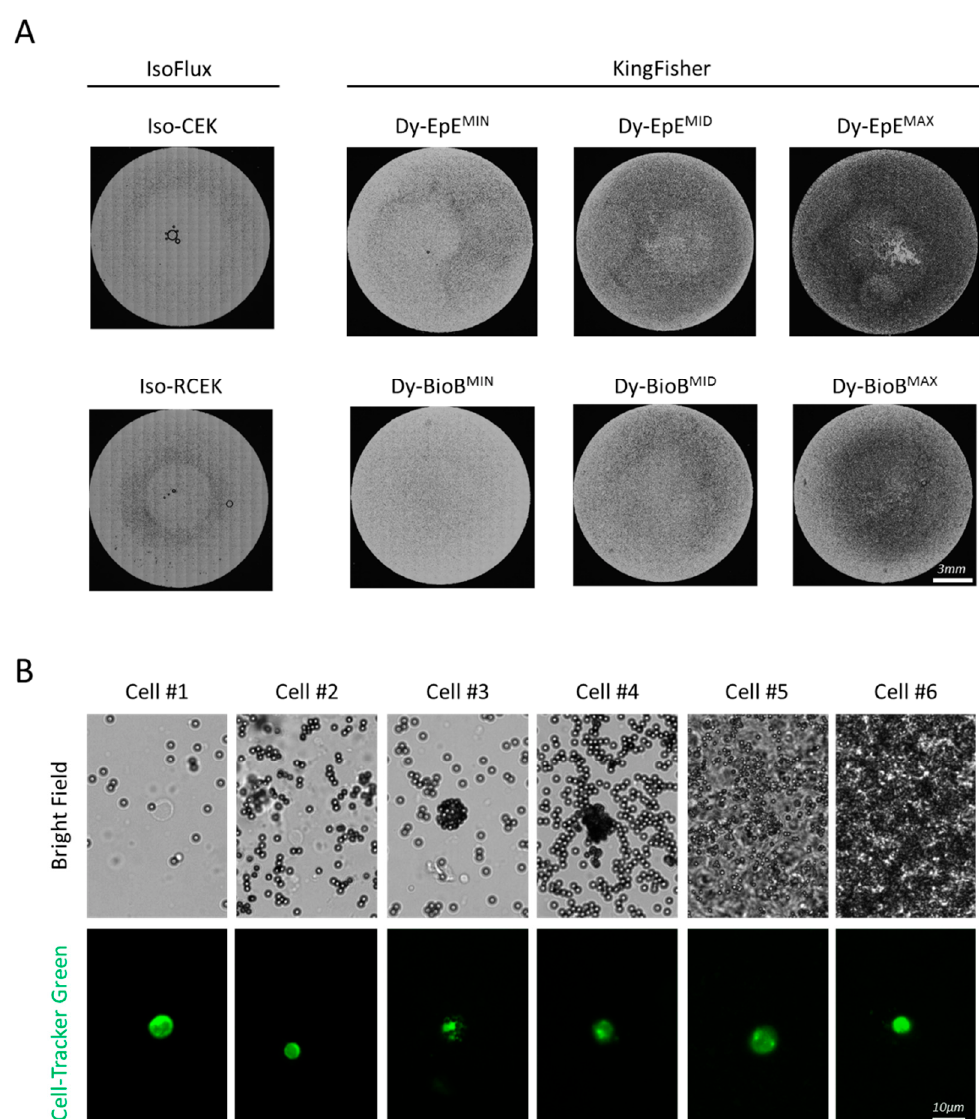
Figure 2. Identification of enriched pre-labelled cells among the beads. ( A ) Distribution of Iso-CEK, Iso-RCEK, Dy-EpE MIN , MID , MAX and Dy-BioB MIN , MID , MAX beads in field of a three-field microscope slide used for enumeration of enriched cells. Each image is a montage of all 357 tiled bright field images covering the complete field. ( B ) Six individual cells identified in one same sample enriched with Dy-EpE beads.